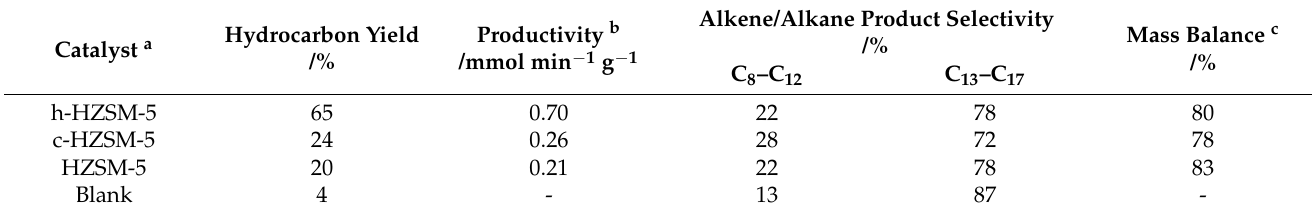
Table 3. Yield and product selectivity for the catalytic cracking of oleic acid a .